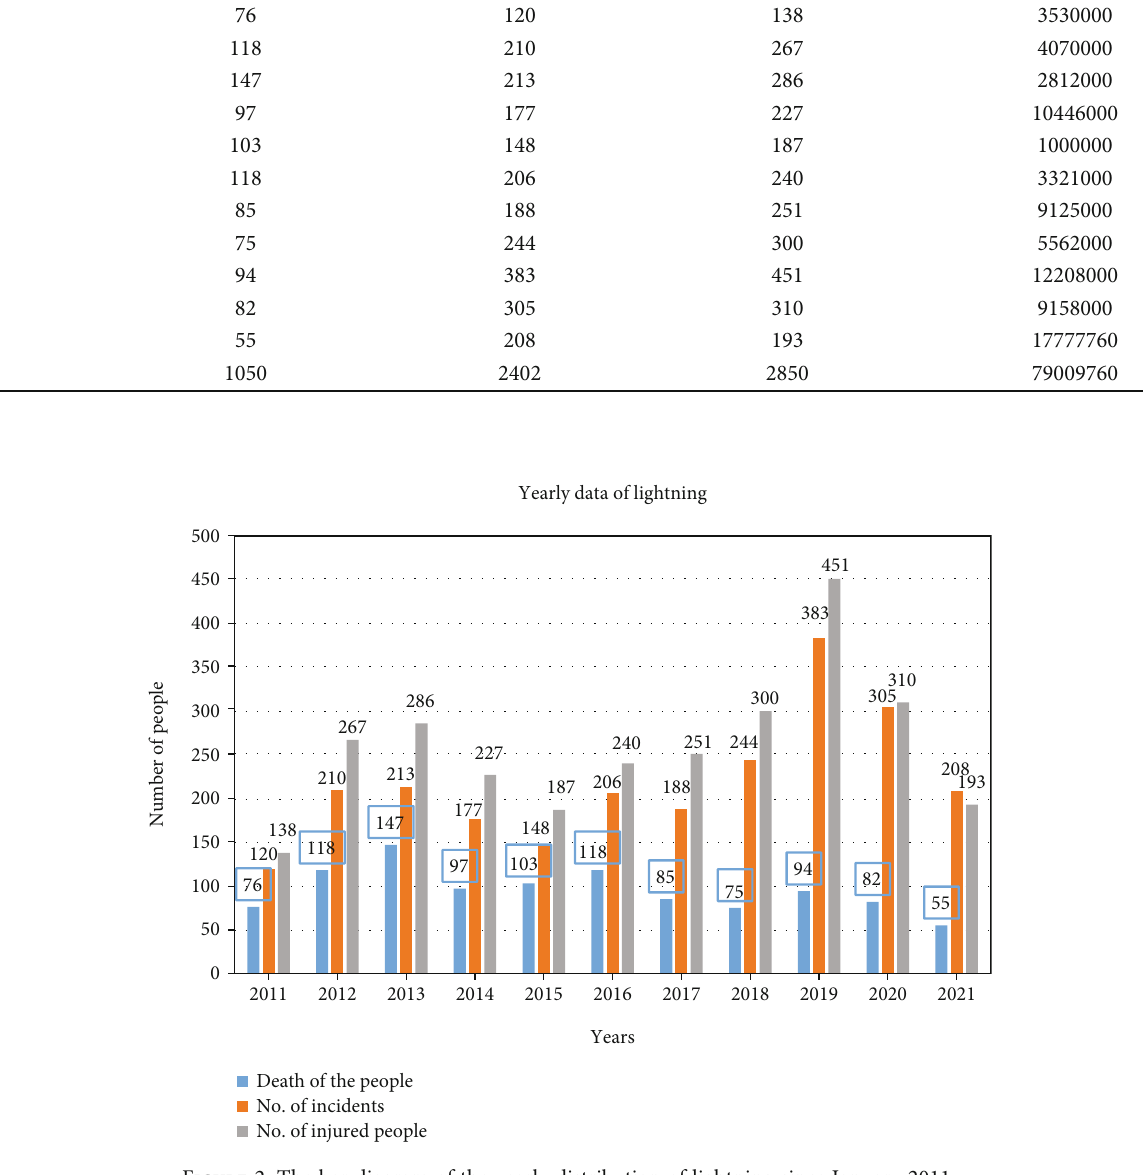
Figure 2: The bar diagram of the yearly distribution of lightning since January